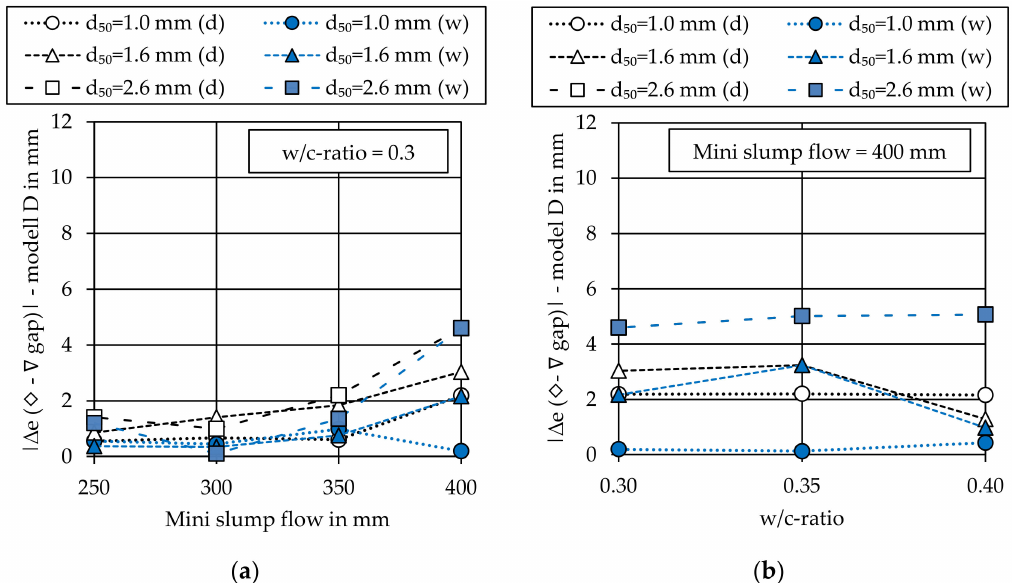
Figure A3. Deviation between the calculated penetration depths using octahedral gaps ( real measured penetration depths depending on ( a ) the mini slump flow and ( b ) the